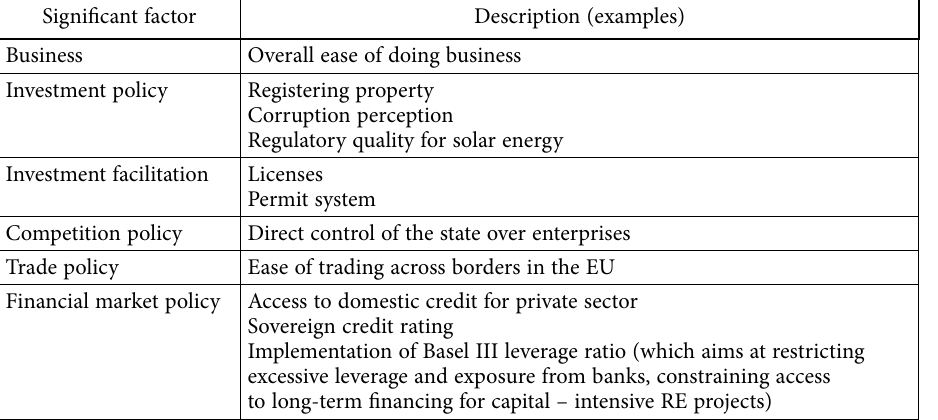
Table 6. Policy drivers for investment flows in renewable power Significant